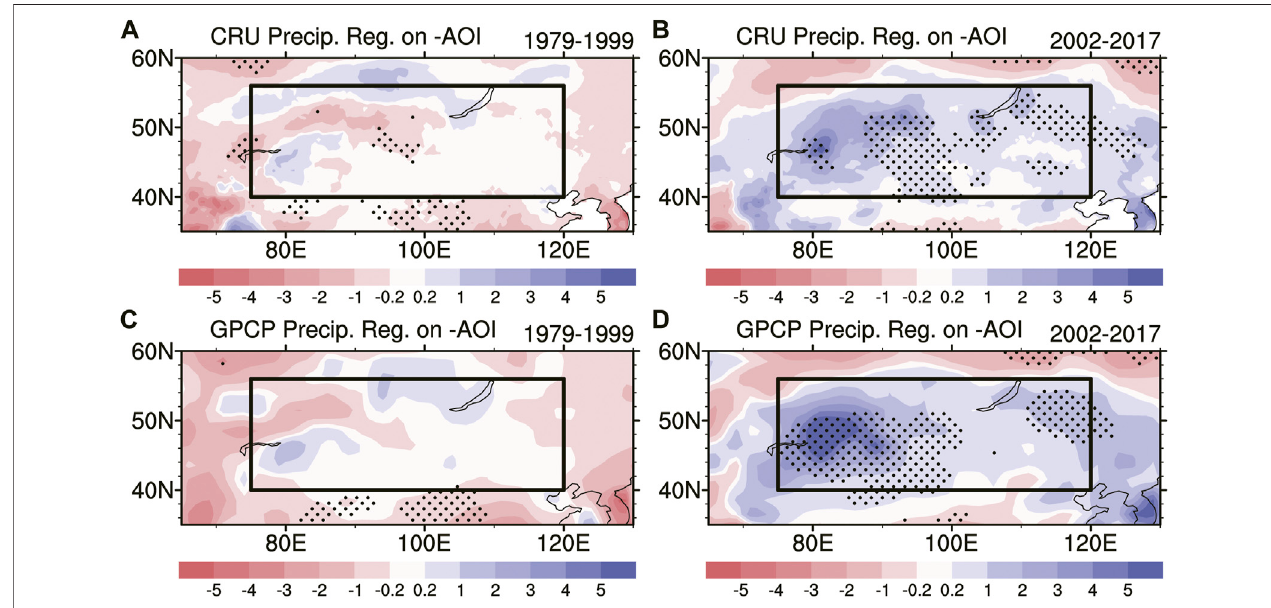
FIGURE 2 | (A, B) Regression maps of the winter precipitation (units: mm month − 1 ) upon AOI multiplied by − 1 ( − AOI) during (A) 1979 – 1999 and (B) 2002 – 2017. The precipitation in (A, B) is derived from the CRU data. (C, D) As in (A, B) but for the results derived from the GPCP data. The black frame denotes the location of the study area (40 ° – 56 ° N, 75 ° – 120 ° E). The dotted areas indicate statistical signi fi cance at the 95% con fi dence level based on the Student ’ s t -test.